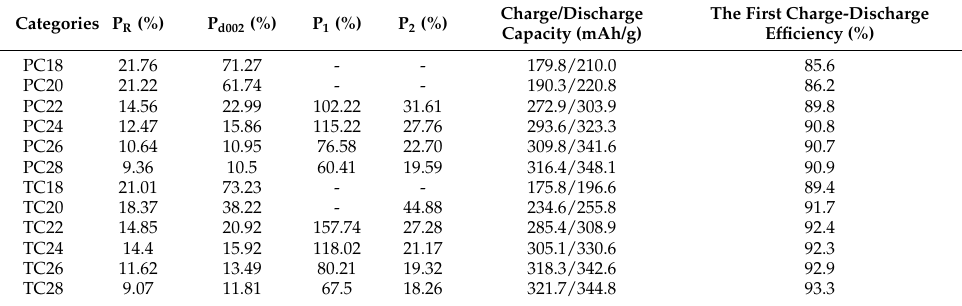
Table 5. The degree of disorder and lithium performance of petroleum coke and pitch coke at different heat treatment